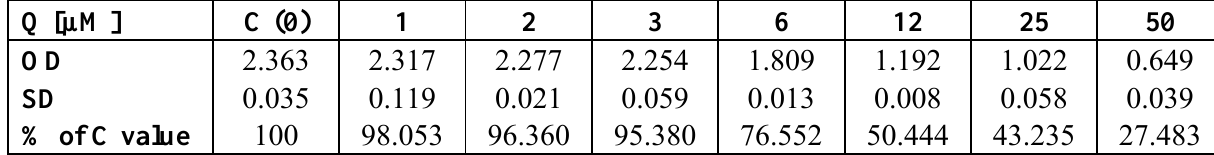
Table 2. Cytotoxic effect of Q on cells of DB-resistant line, as related to drug concentration after 72h; p < 0.001 for optical density (OD) of C vs . all.